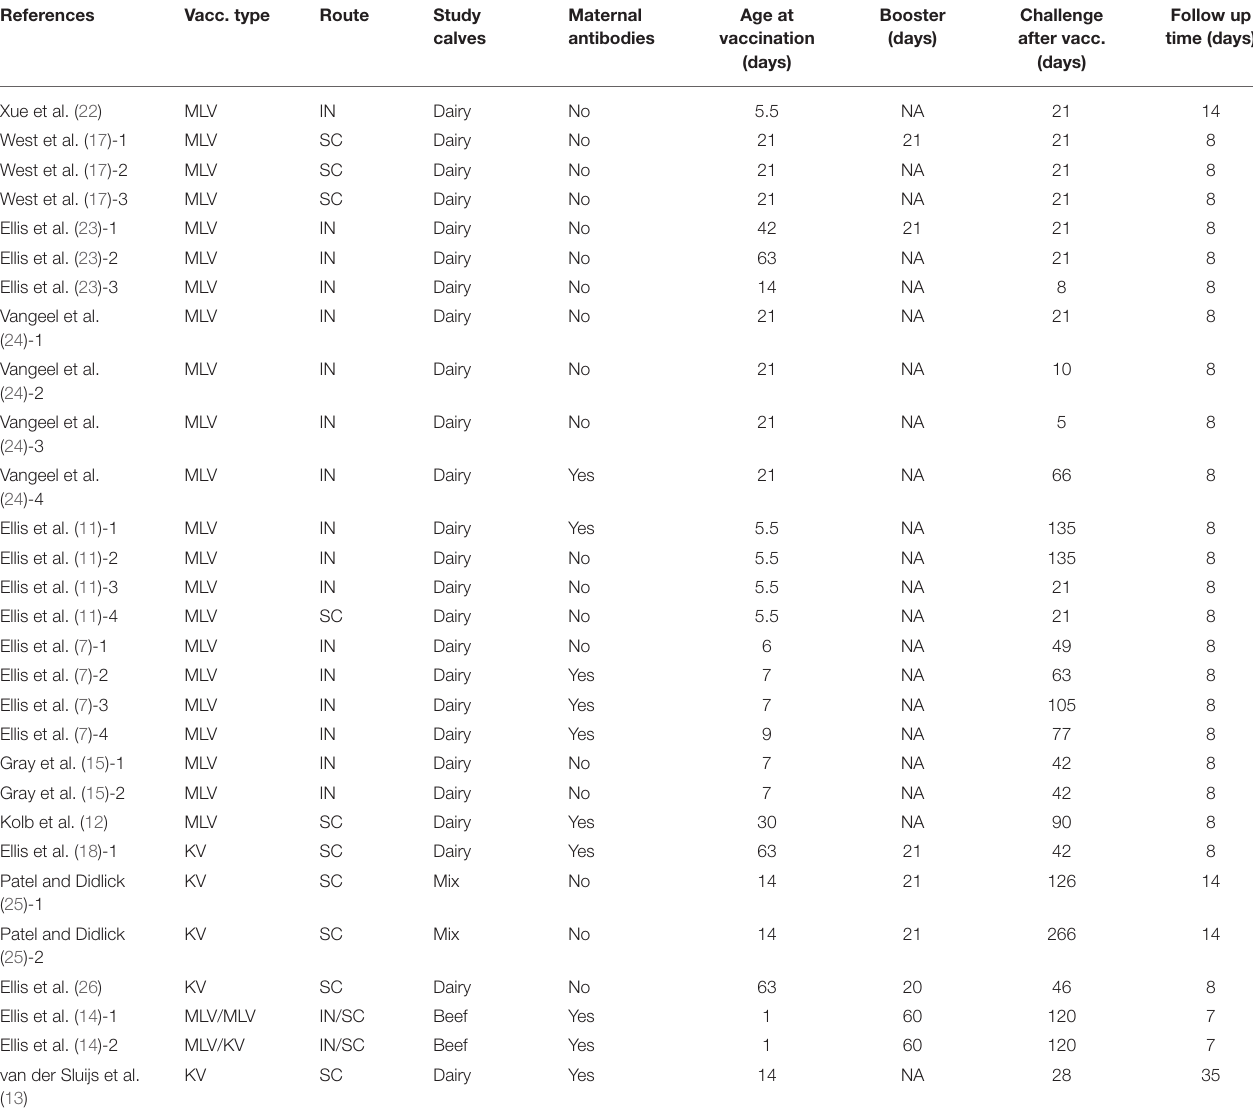
TABLE 1 | Studies evaluating the effect of vaccination on clinical protection against experimental infection with BRSV in